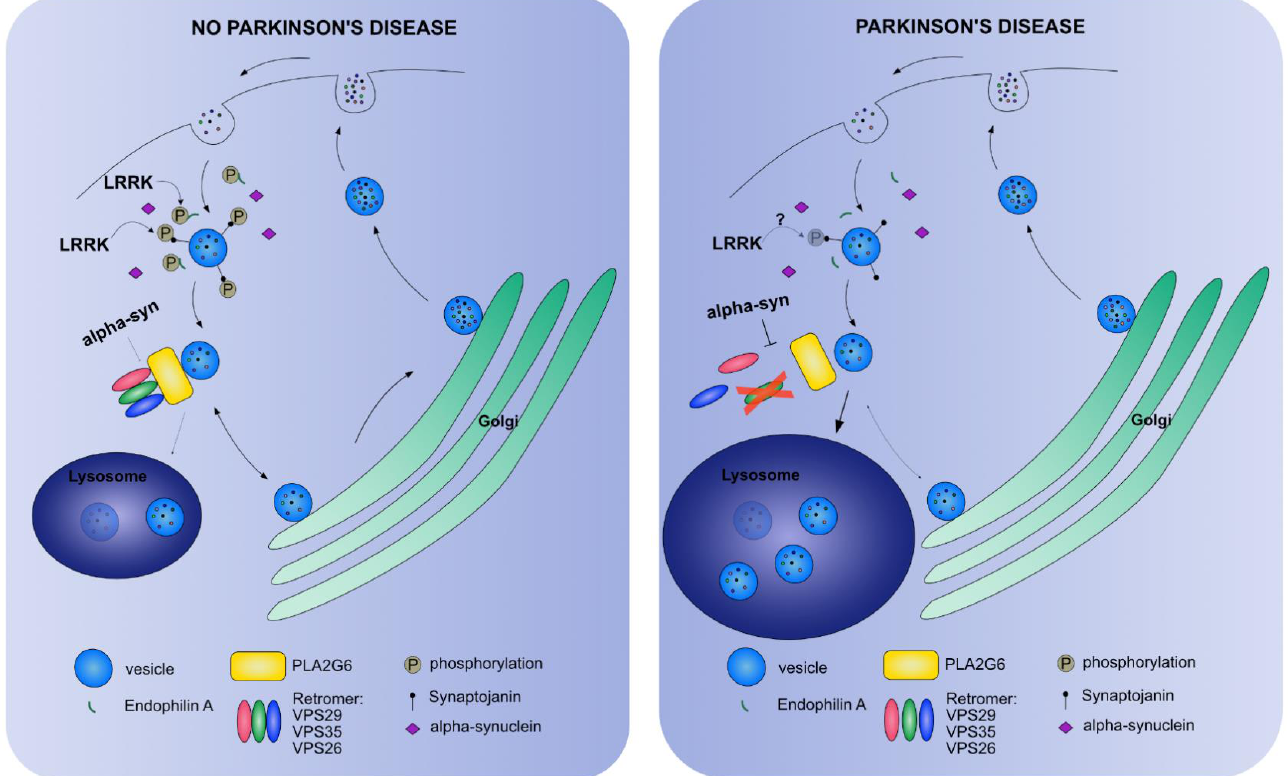
Figure 3. A simplified scheme highlighting processes in which PD-related proteins function in the endo-lysosomal pathway. Vesicles are recycled between the plasma membrane and the Golgi (and ER, not shown). LRRK-dependent phosphorylation of Endophilin A and Synaptojanin, and alpha-synuclein are important to facilitate in the endocytosis of vesicles. Recycling vesicles pass the retromer in conjunction with PLA2G6 to continue to the Golgi to recycle their cargo. A small number of vesicles will be transported to the lysosome to be degraded. In PD, the recycling of vesicles is disturbed by defective endocytosis or a dysfunctional retromer that is inhibited by alpha-synuclein. The effect of PD-related mutations on LRRK2-dependent phosphorylation remains unclear. The net effect is that the vesicles are not recycled to the Golgi, but are translocated to the lysosomes that expand and result in neurodegeneration.